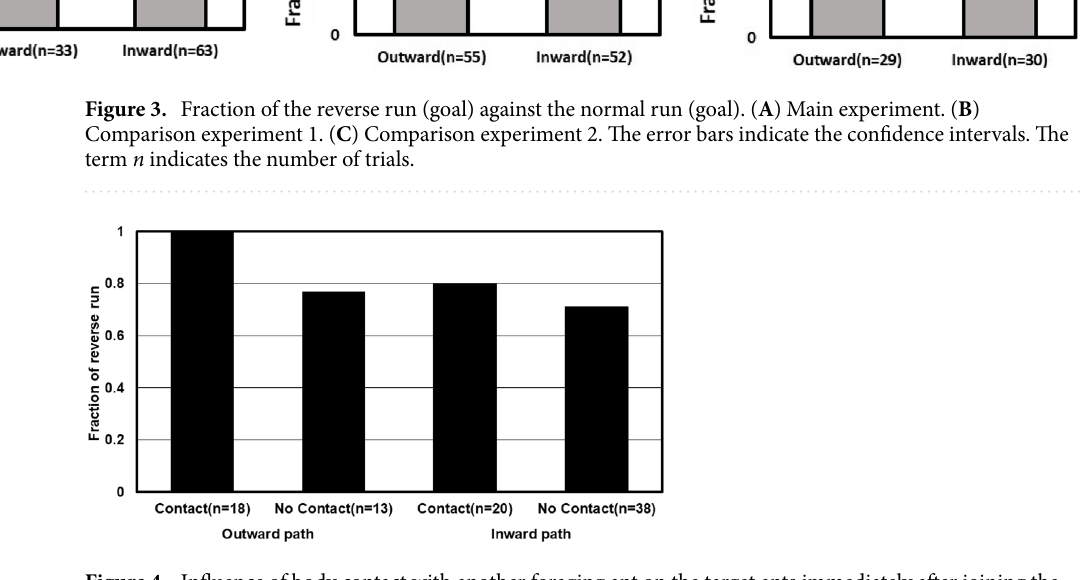
high probability (= Prob ( k )) on each time step. After selecting one direction from two (− x and + x ), agents scan three cells in the direction of movement. Using pheromone concentrations on those three cells, they update their positions. If agents reach coordinates satisfying their y -coordinate = 4 or 0, those agents update their position by select- ing not three but two coordinates since they are located on the edges of the bridge.